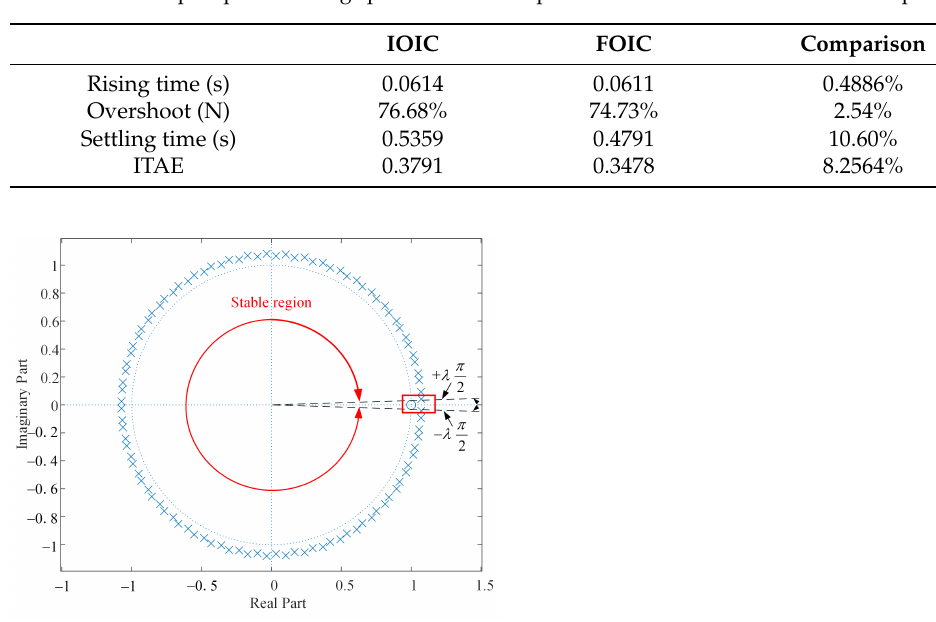
Figure 15. Force step response curve comparison for IOIC and FOIC. Table 8. Force step response average performance comparison for IOIC and FOIC with ten repetitions.